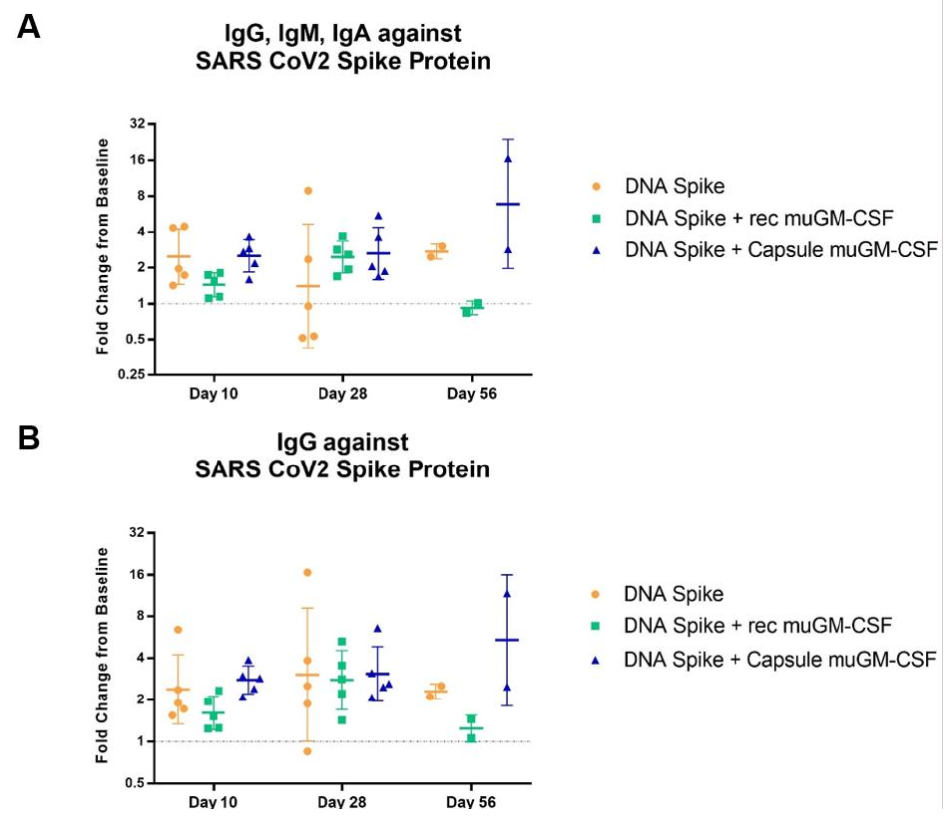
Figure 5. Antibodies against SARS-CoV-2 Spike Protein Detected by ELISA.Mice were immunized with a single dose of spike DNA plasmid with or without GM-CSF (recombinant or secreted by encap- sulated cells) as an adjuvant. B cell response was measured at day 10 and 28 by quantification of the serum’s antibodies. ( A ). IgG, IgM, IgA against SARS CoV2 Spike Protein. Day 10, p value * = 0.0324; Day 28, p value * = 0.0277; Day 56, p value **** < 0.0001. ( B ). IgG against SARS CoV2 Spike Protein. Day 10, p value * = 0.0162; Day 28, p value ** = 0.0089; Day 56, p value **** < 0.0001. Fold change is calculated between the baseline and the day of sacrifice values. Data analysis are represented with geometric means with geometric